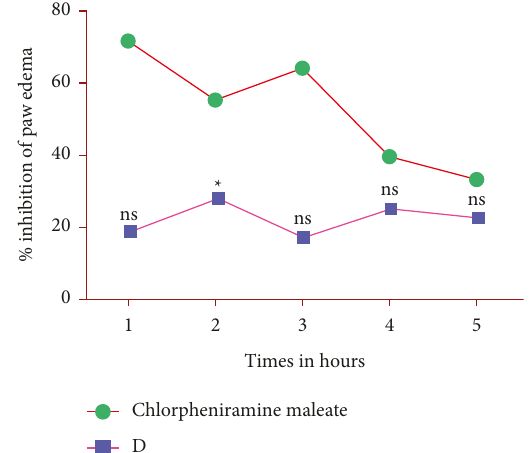
Figure 4: Percent inhibition produced by compound D (100mg/ kg) in the bradykinin-induced paw edema model in mice. Each percent point represents the mean SEM for a group of 8 mice. Data were analyzed by Student’s t -test. n.s, nonsignificant values 0 . 05, compared to the standard drug (HOE 140). ± <